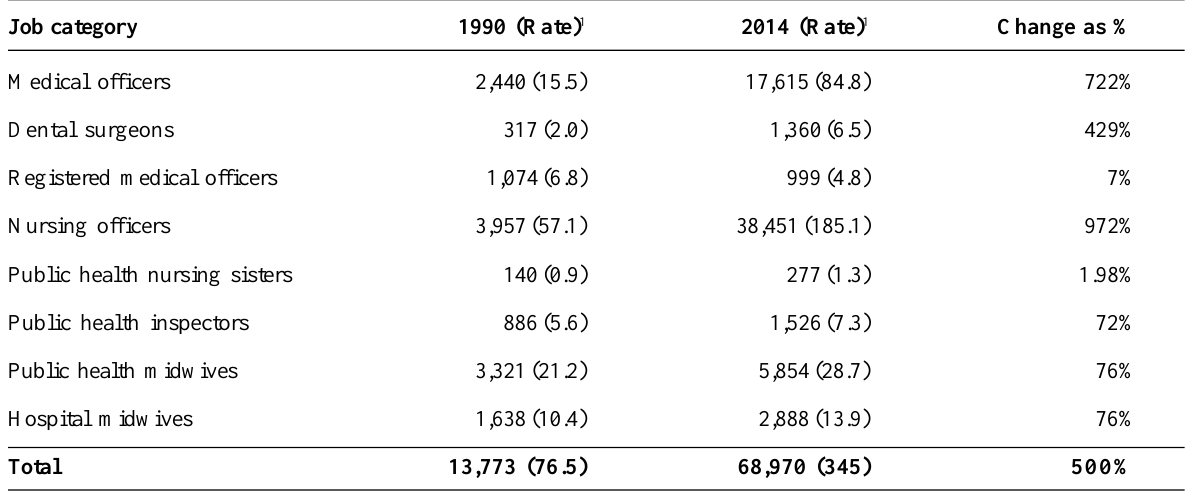
Table: 1 Composition of healthcare service personnel